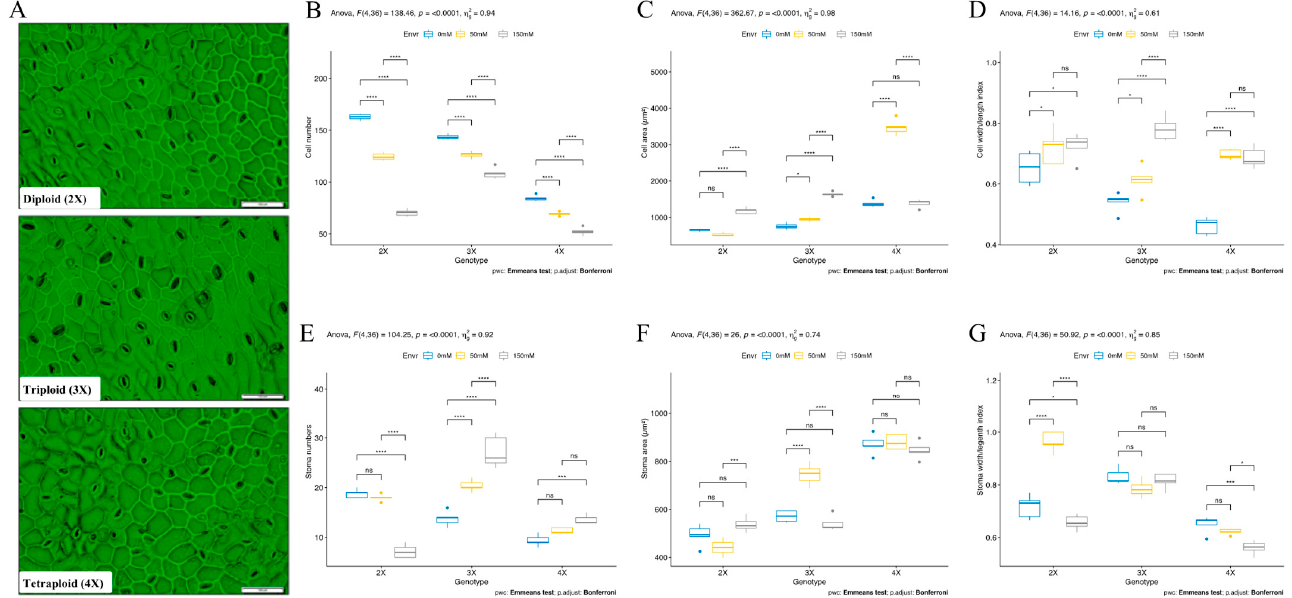
Figure 4. Effects of salinity stress on cytologic observation of different ploidy level sugar beet plants ( Beta vulgaris L.) at the vegetative stage. ( A ) Microscopic observations of cell and stomas, ( B ) cell number, ( C ) cell area, ( D ) cell width/length index, ( E ) stoma numbers, ( F ) stoma area, ( G ) stoma width/length index were measured in 42-day-old plants that were exposed to 0 mM, 50 mM, and 150 mM salt (NaCl) stress from germination. Means (± standard deviation) within the same graph followed by the Emmeans test and p -value adjusted by the Bonferroni method from five independent biological replicates ( n = 5). Asterisk indicates that ns—non-significant; * significant at p < 0.05; *** significant at p < 0.001; **** significant at p < 0.0001.